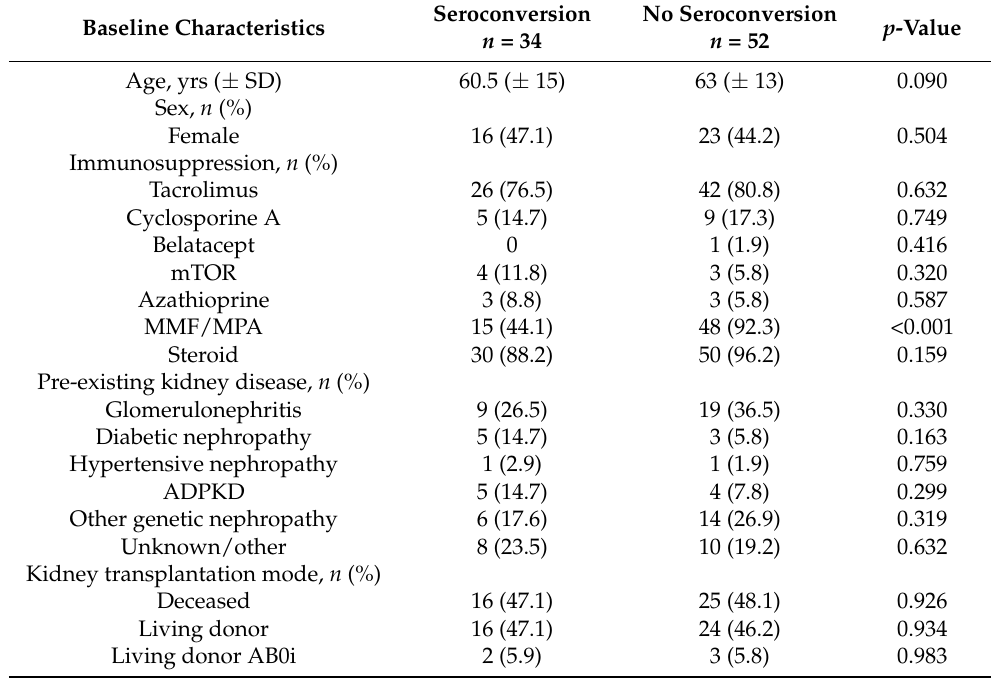
Table 3. Baseline characteristics of SARS-CoV-2-naïve kidney transplant recipients with determined anti-SARS-CoV-2 serology after vaccination with BNT162b2 (BioNTech/Pfizer). AB0i: AB0 incom- patible; ADPKD: autosomal dominant polycystic kidney disease; IQR: interquartile range; MMF: mycophenolate mofetil; MPA: mycophenolic acid; mTOR: mechanistic target Of rapamycin; SD: standard deviation; yrs: